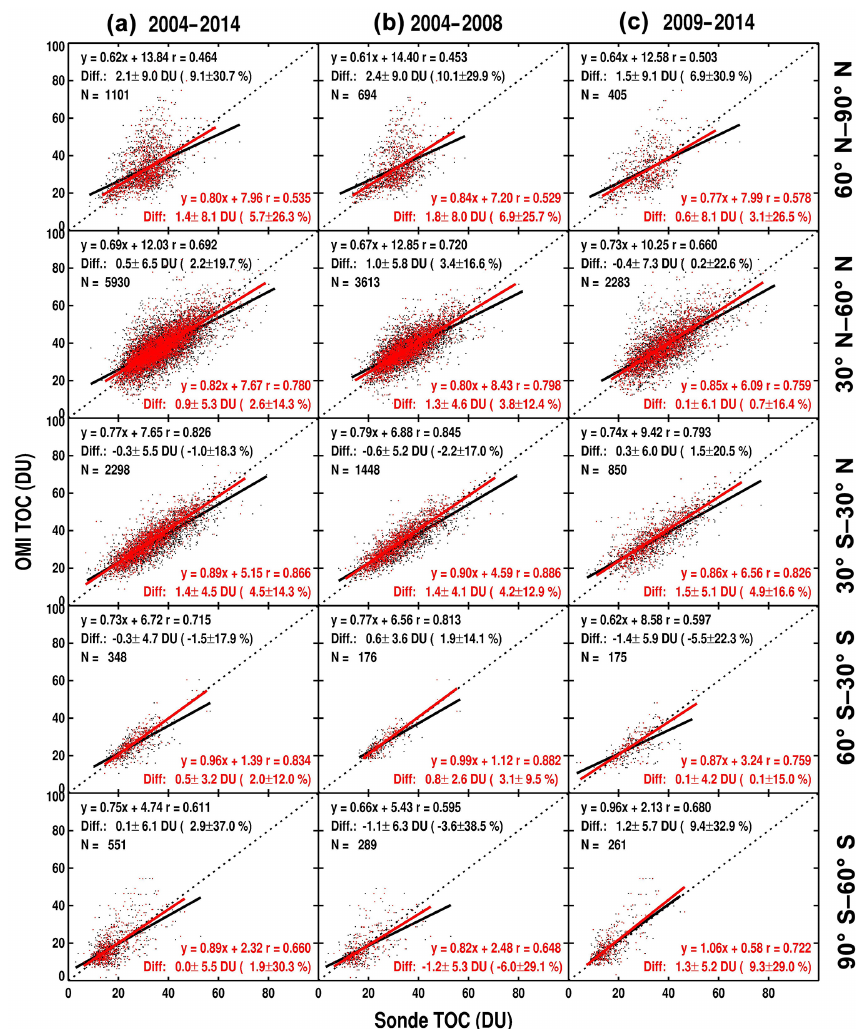
Figure 9. Similar to Fig. 8 but for comparison of tropospheric ozone columns (TOCs).